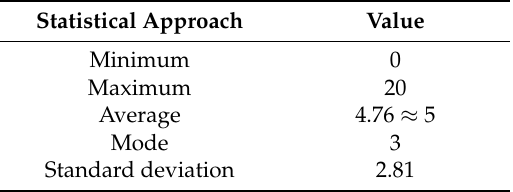
Table 4. Basic statistics of duplicate intersection sets for simulation in Figure 2.